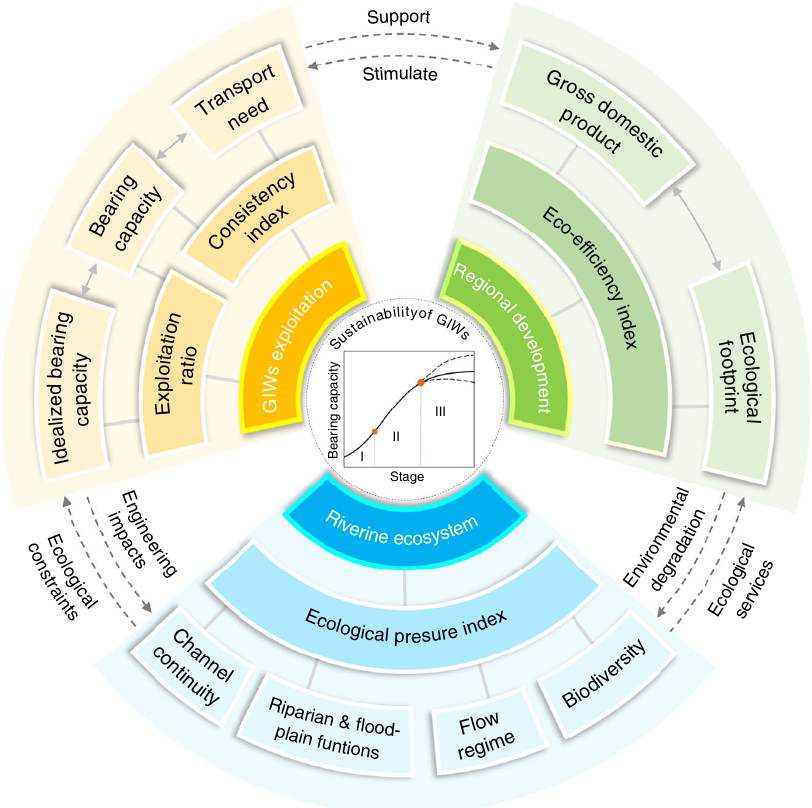
Fig. 1 Hierarchical framework for assessing sustainability of global Golden Inland Waterways (GIWs). The framework integrates three primary sectors, i.e. GIWs exploitation, riverine ecosystem, and regional development. First, the stage of development for each of the GIWs is primarily determined from the regional development sector. Second, regional development would stimulate waterway transport need and require expansion in bearing capacity of speci fi c GIWs. Third, the exploitation ratio is identi fi ed in the GIWs exploitation sector for the goal of regional development, but should not exceed a certain threshold due to ecological considerations. Fourth, ecological pressure from engineering practice is assessed in the riverine ecosystem sector to maintain the fundamental ecological services for regional development. Finally, sustainability of GIWs is estimated in terms of the metrics from the three